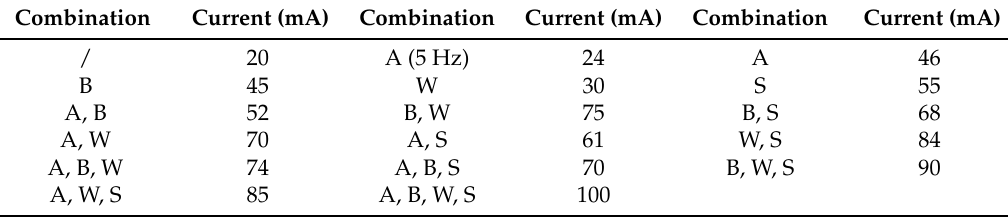
Table 1. Energy cost of different sensor combinations measured in mA. Sensors that were active were labeled: A, accelerometer (50 Hz), A (5 Hz), accelerometer (5 Hz); S, sound; B, Bluetooth; W, WiFi.